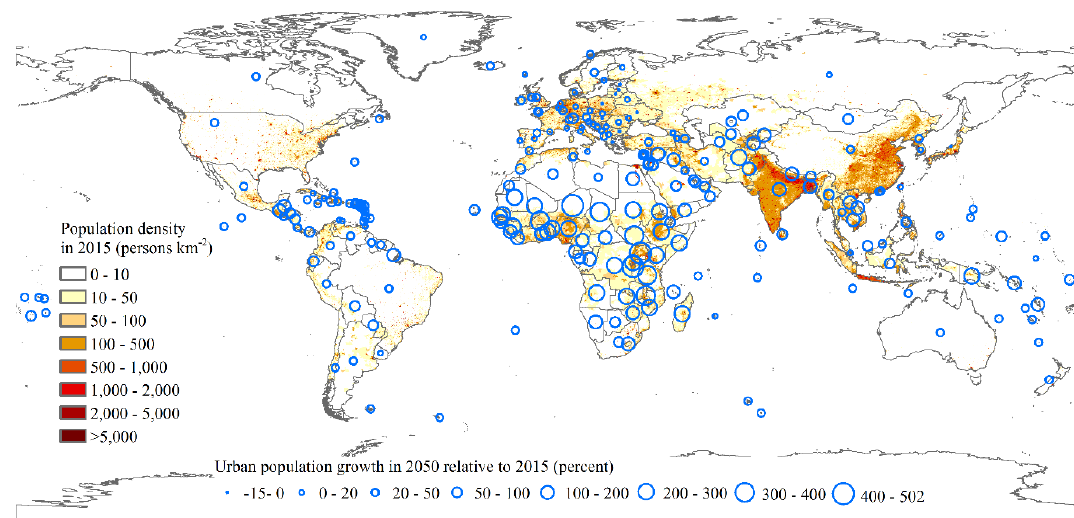
Figure 7. Global distribution of population density in 2015 [247] and the projected urban population growth in 2050 relative to 2015 in each country [17].